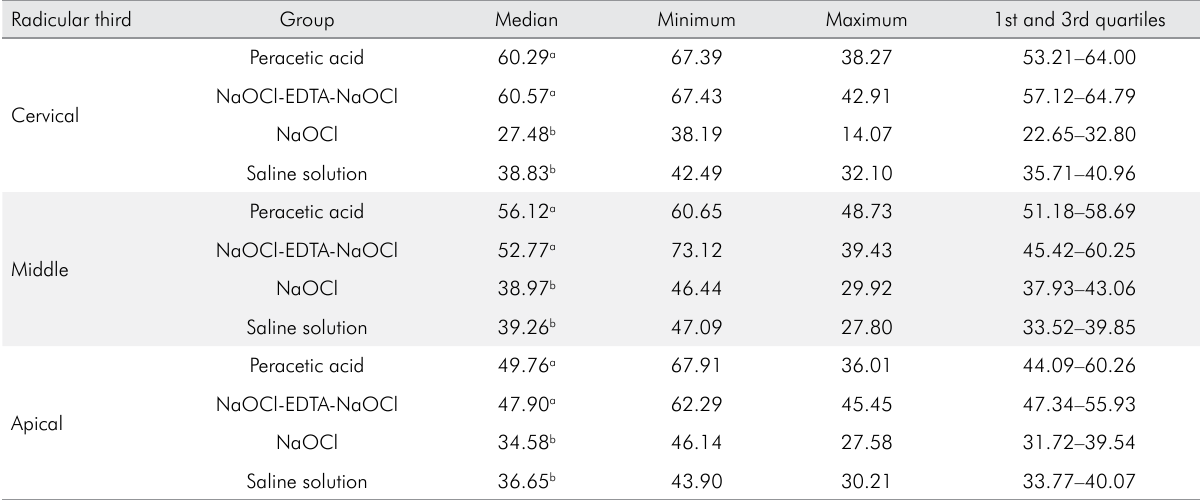
Table 3. Penetrability of root canal sealer into dentinal tubules (in percentage) after root canal preparation using different irrigant